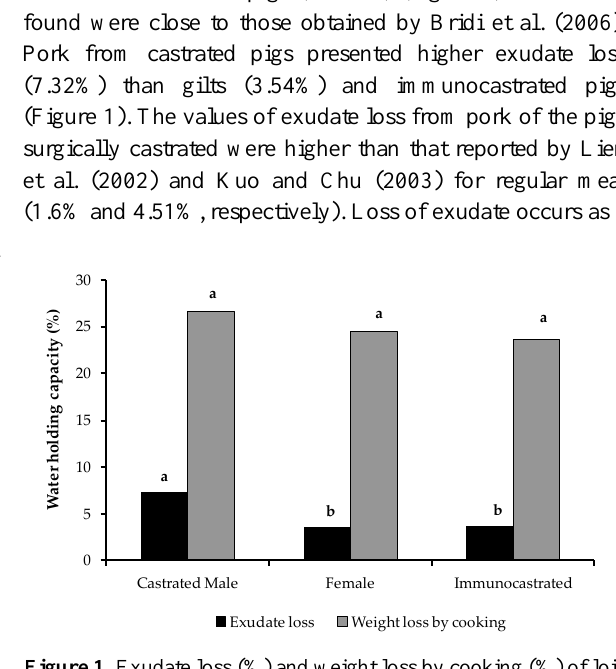
Figure 1. Exudate loss (%) and weight loss by cooking (%) of loin of male immunocastrated, surgical castrated and female pigs. Means followed by different letters in the line differ between them by Tukey test (p 